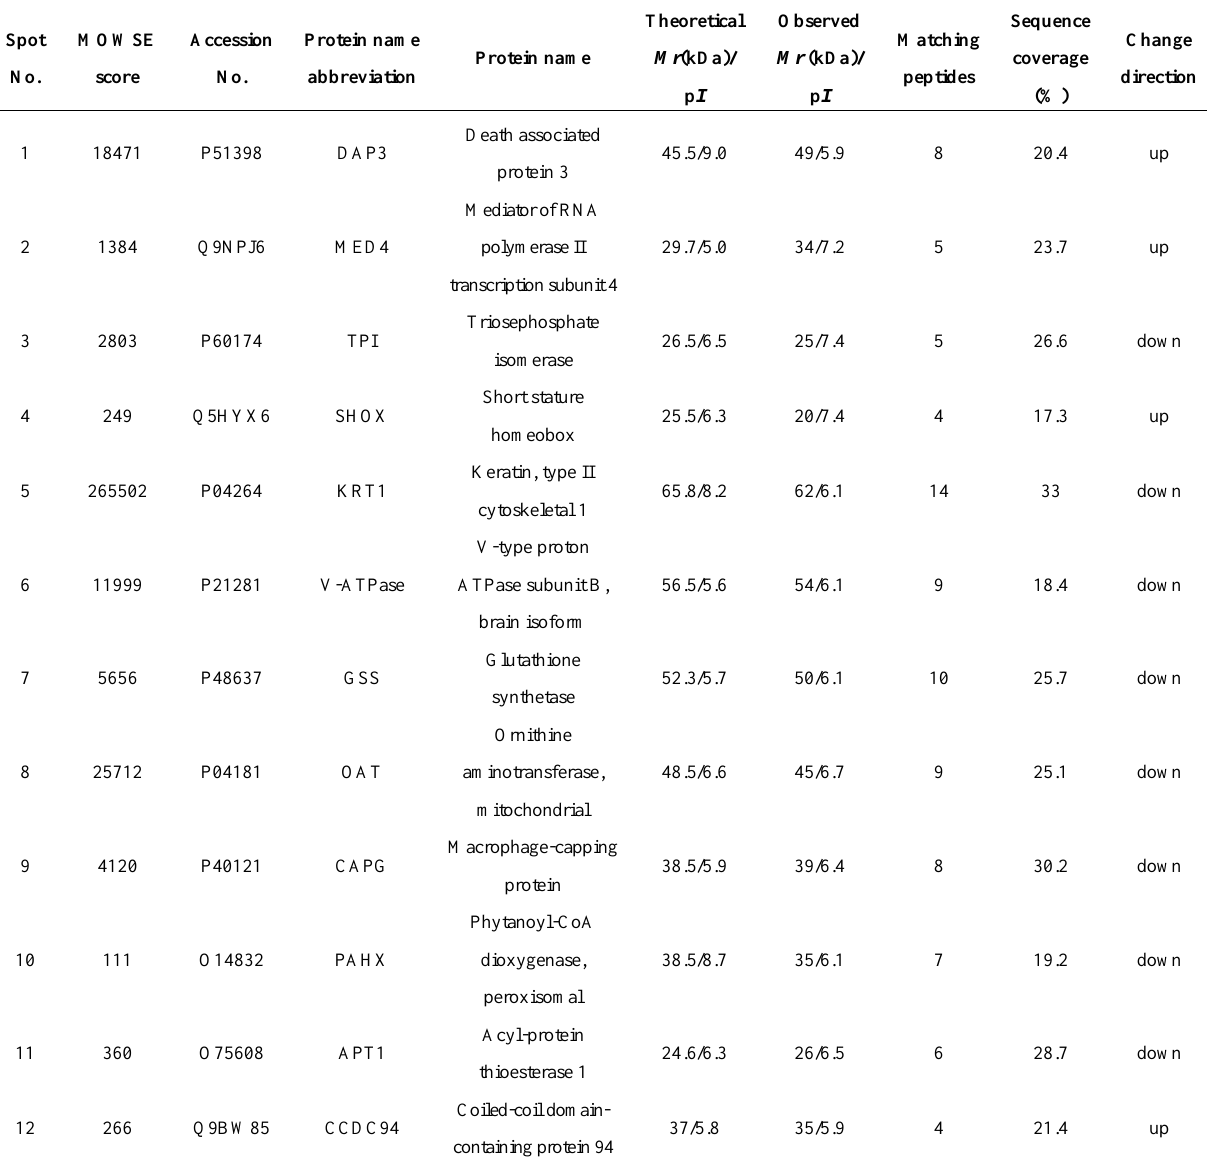
Table 1. Identified proteins. The spot number, MOWSE score, UniProt database accession number, and protein name abbreviation are shown, followed by the theoretical and observed molecular mass ( Mr ) and isoelectric point (p I ). The number of matching peptides and sequence coverage were calculated using Biotools™ software. The direction of the change in protein expression is also